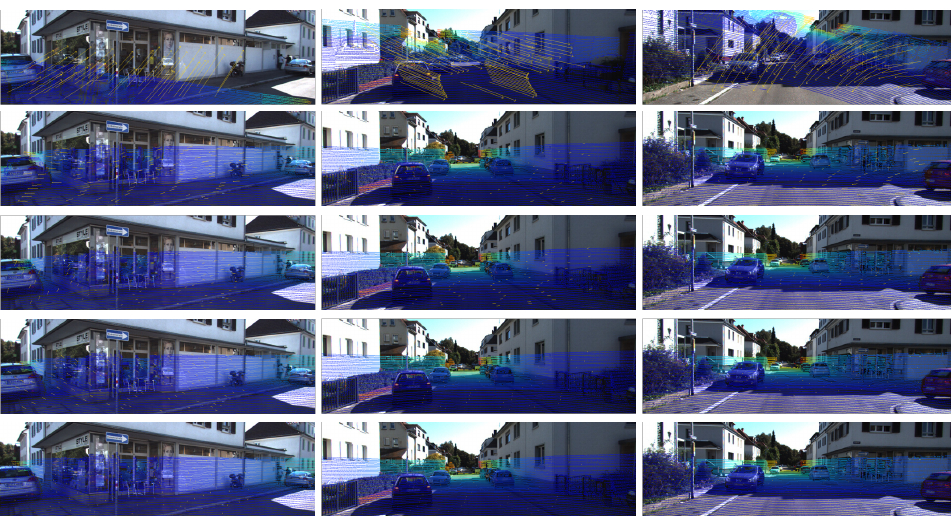
Figure 4. Examples of the predicted calibration flow represented by yellow arrows. Each row of pictures shows the calibration flows predicted by the models of different initial error ranges, from N 1 to N 5 . (from top to